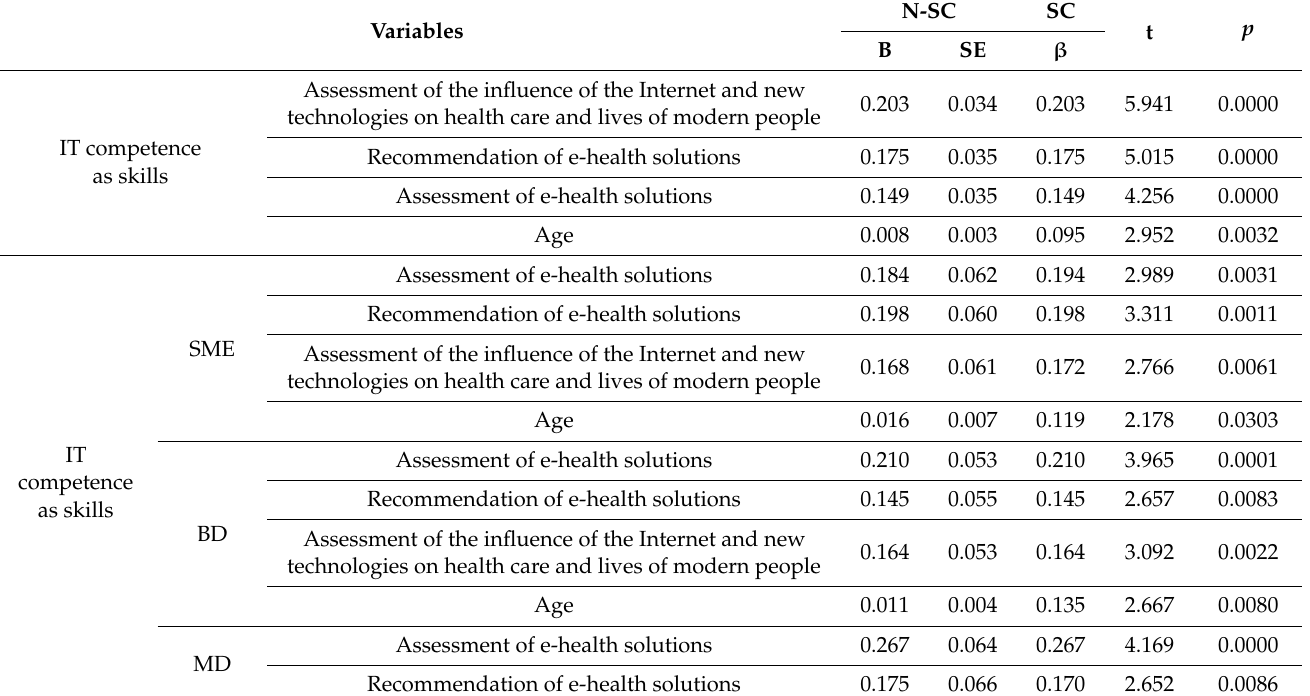
Table 7. Nurses’ IT competence in relation to skills depending on selected variables (assessment of the influence of the Internet and new technologies on the health care and lives of modern people, assessment of the e-health solutions, recommendations of e-health solutions and age of